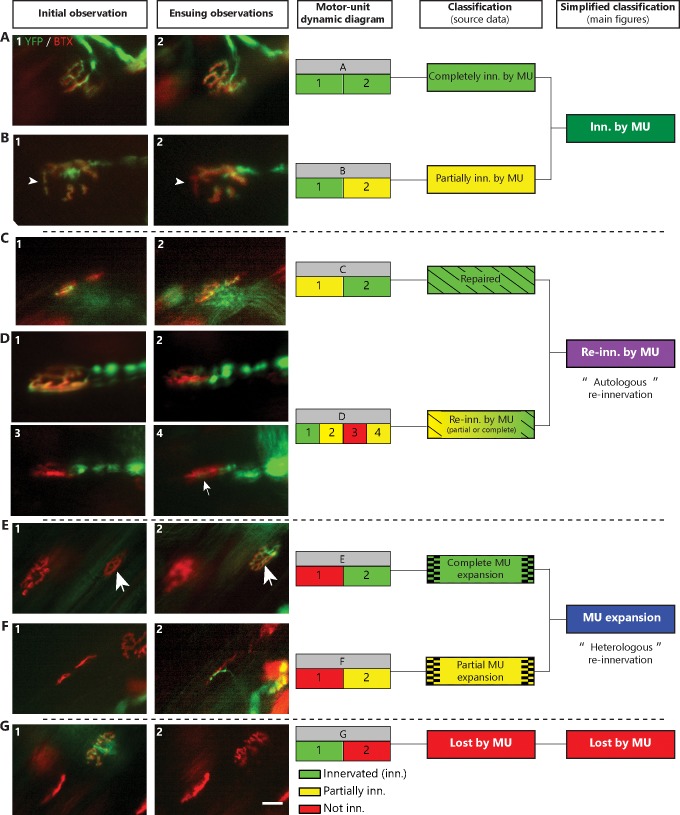
Classification of NMJs within single MUs.Representative examples of the initial and subsequent observation of NMJs classified as completely innervated (inn.) (A) or partially innervated (B) repaired (C) re-innervated (partially or completely) by the MU (D) as a complete (E) or a partial (F) MU expansion or finally as lost by the MU (G) (Green: YFP-labeled axon; Red: nAChR). For each example, the MU dynamic diagram and the color- and pattern-coded classification for the supplementary and main figures (simplified) is shown. Arrowheads in (C) indicate the postsynaptic site which re-innervated, the arrow in (D) (3) shows that a small part of the endplate re-innervated and big arrows in (E) represent newly innervated NMJ (expansion). Note that the NMJ presented in (D) is the same as the one presented in Figure 2A4. Scale Bar: 25 μm.